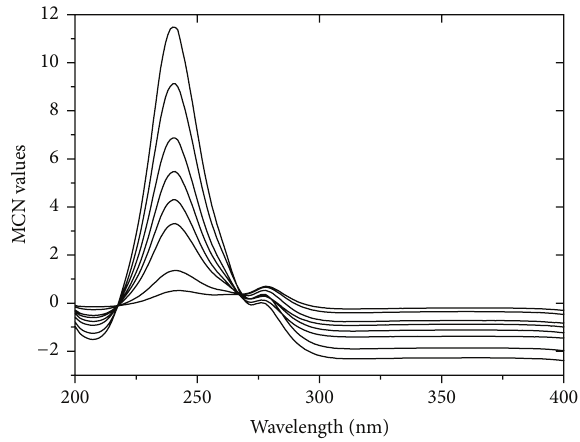
Figure 10: Mean centered ratio spectra of AA (4–50 𝜇 g/mL) using 8 𝜇 g/mL of RU as a divisor and methanol as